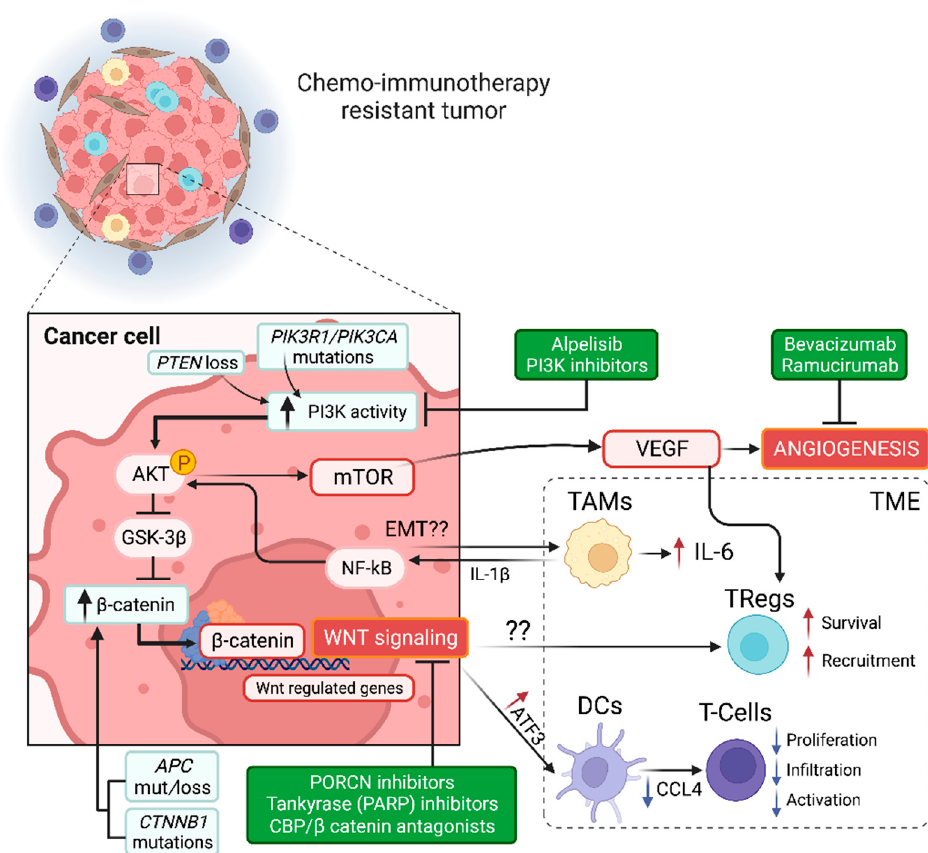
Figure 3. Hypothetical model of chemo-immunotherapy-resistant tumors in advanced GC patient and potential therapeutic interventions. Briefly, aberrant high PI3K activity caused by PIK3CA / PIK3R1 mutations and/or PTEN loss increases Akt activation. In turn, activated Akt stimulates VEGF secretion and angiogenesis via mTOR. Additionally, Akt increases β -catenin activity and Wnt signaling via crosstalk with GSK3 β . Increased Wnt signaling affects the tumor microenvironment (TME) via “immune exclusion”, increasing Treg survival and reducing CD8 + T-cell proliferation, infiltration, and activation via a decrease in CCL4 in dendritic cells (DC). Highlighted potential therapeutic interventions include PI3K inhibitors such as Alpelisib, angiogenesis inhibitors such as bevacizumab or ramucirumab, and Wnt/ β -catenin signaling inhibitors such as porcupine (PORCN) inhibitors, tankyrase inhibitors, or CBP/ β -catenin antagonists.